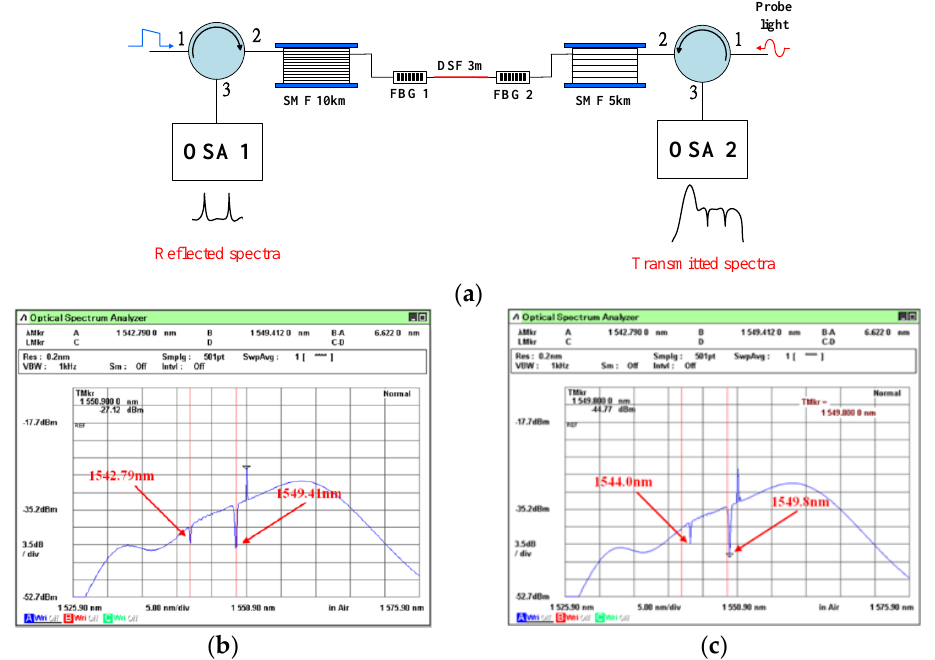
Figure 3. ( a ) Two FBGs are located on both sides of the DSF. ( b ) Before the strain and temperature changes were applied to the FBGs, and ( c ) after the strain and temperature changes were applied to the FBGs.